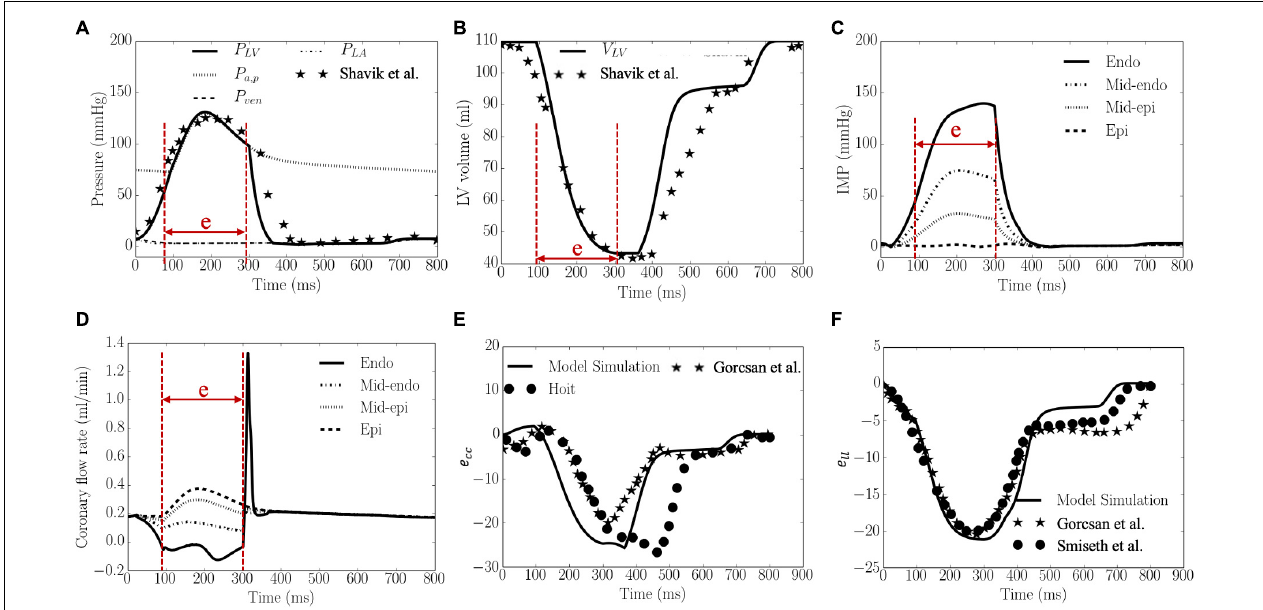
FIGURE 3 | Model predicted results. (A) Pressures, (B) LV volume, (C) IMP, (D) Coronary flow rate, (E) e cc , and (F) e ll waveforms. LV pressure and volume, and e cc and e ll are plotted together with measurements from 3D echocardiography (dots and stars), and were in agreement with clinical measurements in Gorcsan and Tanaka (2011), Hoit (2011) and Smiseth et al. (2016), Shavik et al. (2019), respectively. “e” in panels (A–D) indicates “ejection